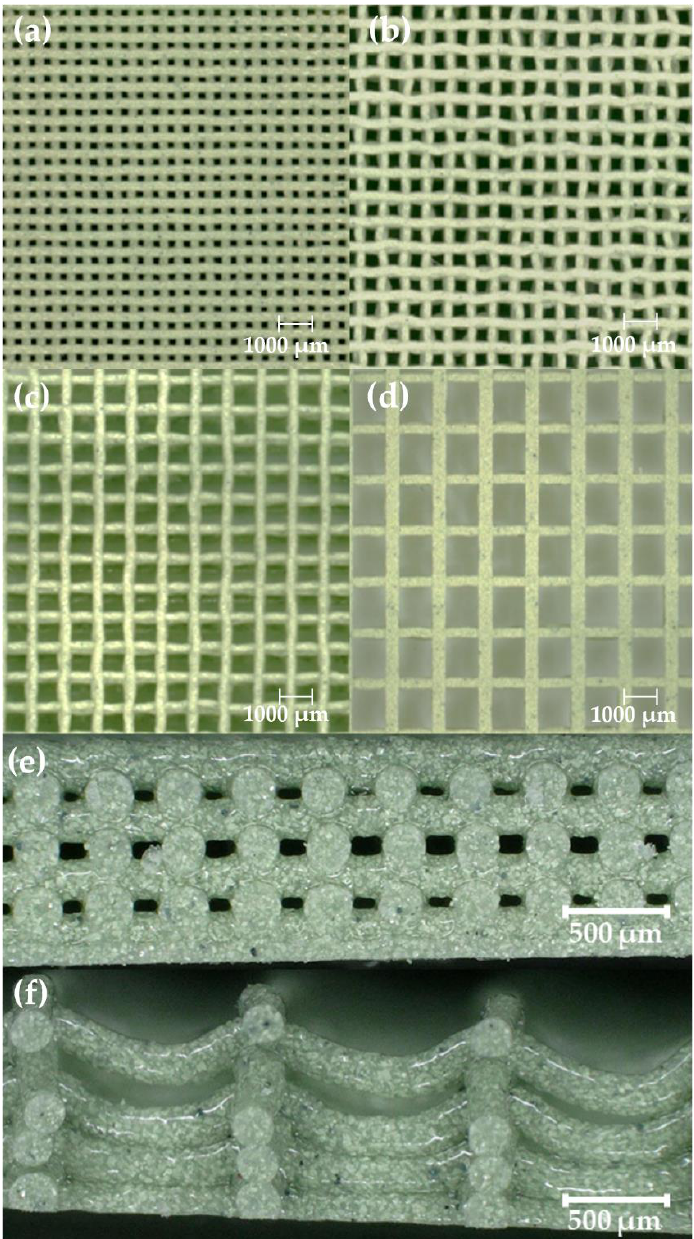
Figure 3. Top view microscopy images of SC parts printed with 50 wt% WO 3 ink using a 250 µ m nozzle at: ( a ) 500 µ m or η = 2; ( b ) 750 µ m or η = 3; ( c ) 1000 µ m or η = 4; and ( d ) 1500 µ m or η = 6. Side view microscopy images (50 × ) of SC parts printed with 50 wt% WO 3 ink using a 250 µ m nozzle showing stable vs. sagging struts in prints with spacing: ( e ) 500 µ m or η = 2; and ( f ) 1500 µ m or η = 6.